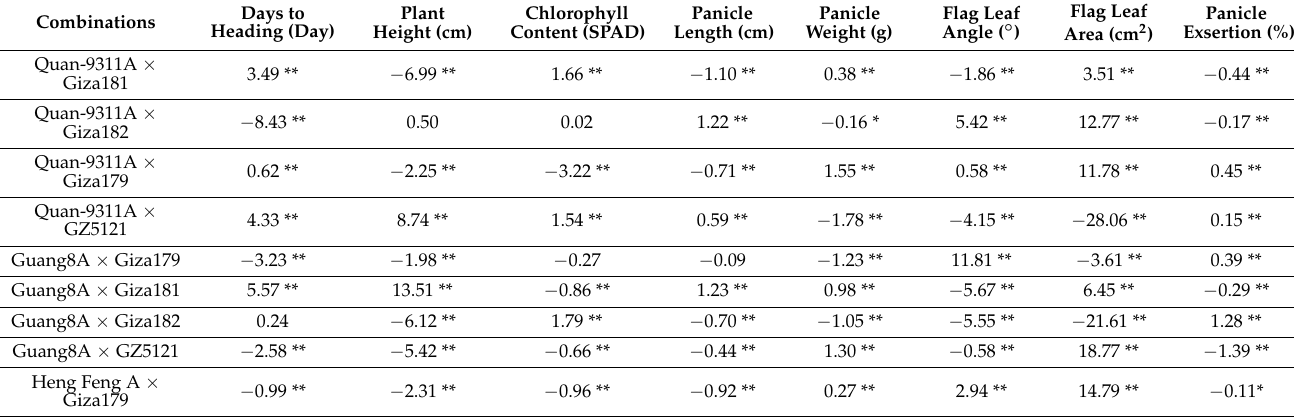
Table 4. Specific combining ability effects of hybrid crosses for studied